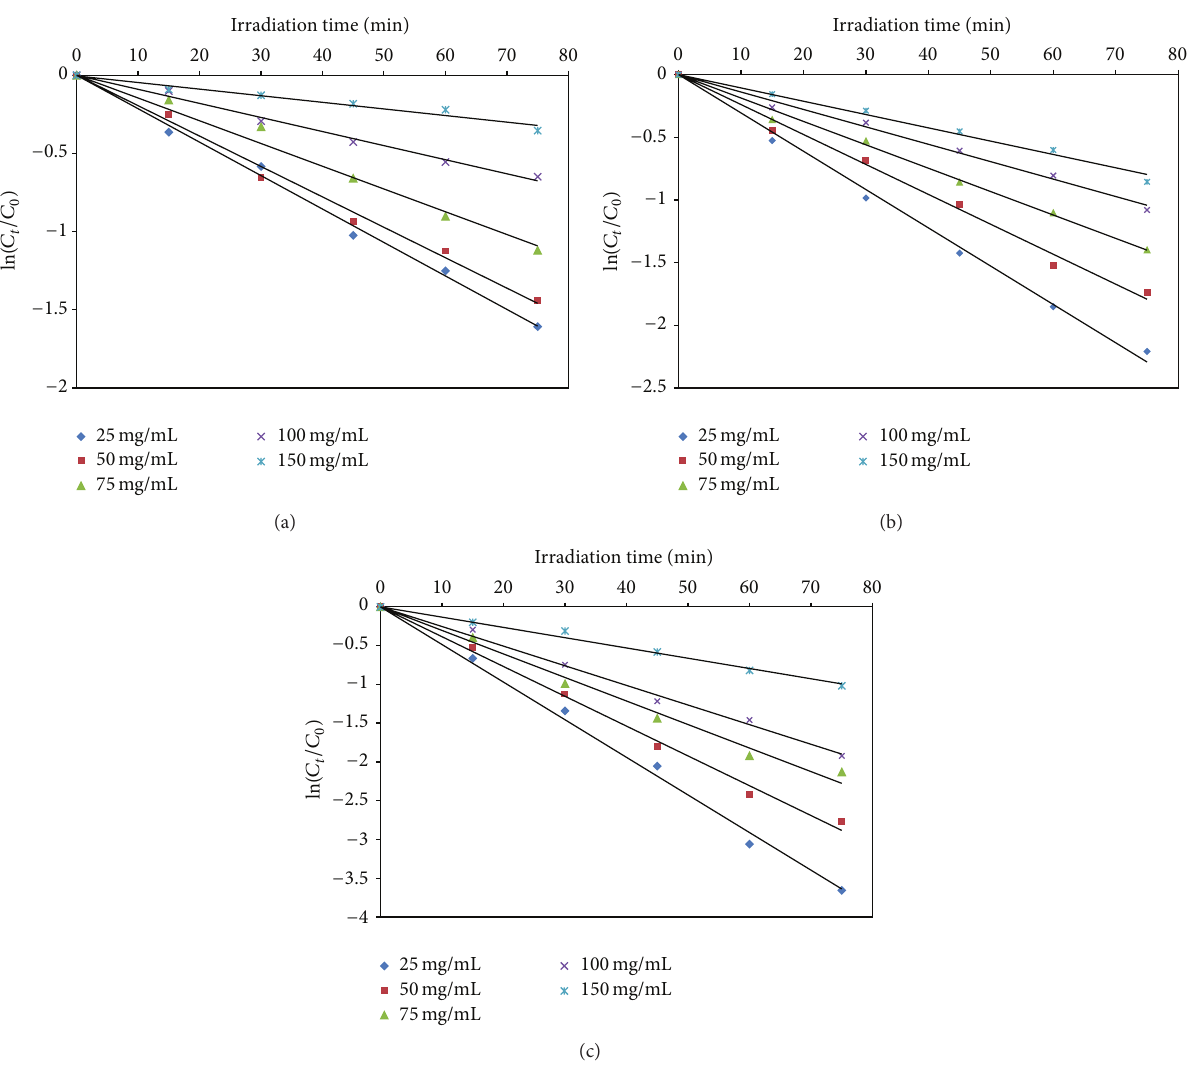
Figure 7: (a) Effect of initial dye concentration on photocatalytic degradation of MG using TiO 2 (P25) (photocatalyst amount = 0.75 g/L and irradiation time = 180min at pH = 7). (b) Effect of initial dye concentration on photocatalytic degradation of MG using TiO 2 /NC (photocatalyst amount = 0.75 g/L and irradiation time = 180min at pH =